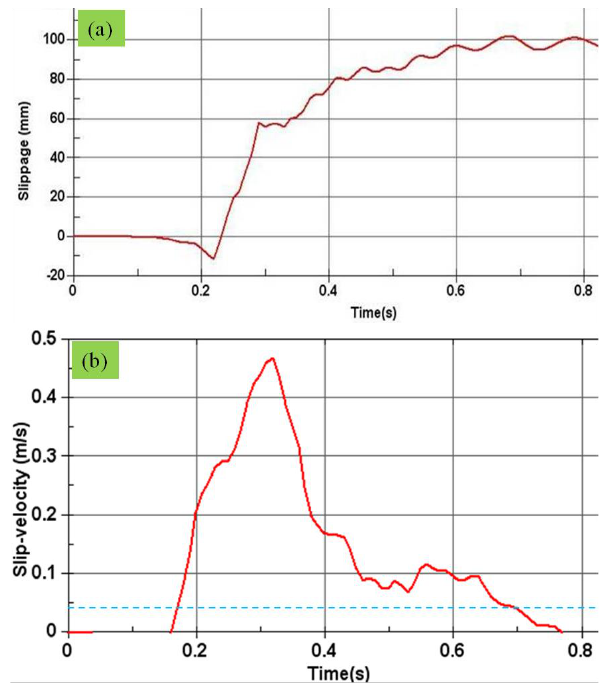
Fig. 14. Numerically simulated time histories of maximum slip-displacement (slippage) of the UFD device (at location M in Fig. 1) corresponding to the FST scenario of the R-LPR (a) and of the slip-velocity obtained by differentiating the slip-displacement w.r.t. time (b) . The dotted (blue) horizontal line marks the assumed threshold slip-velocity of 0.04ms − 1 only below which the coefficient of dynamic frition varies significantly.